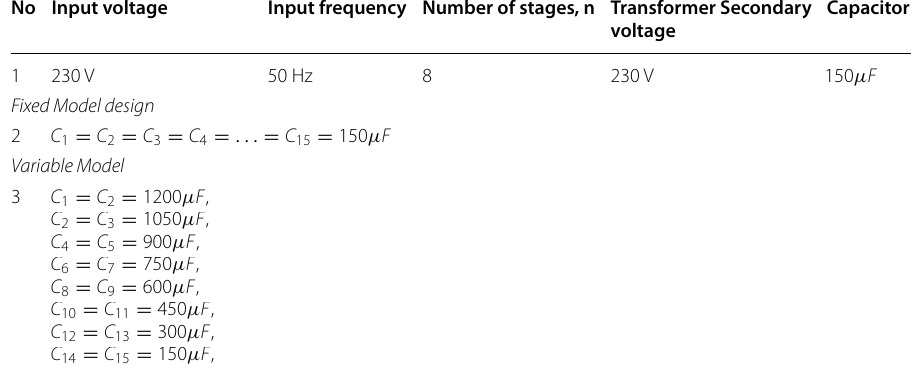
Table 1 Simulation parameters of the HVDC